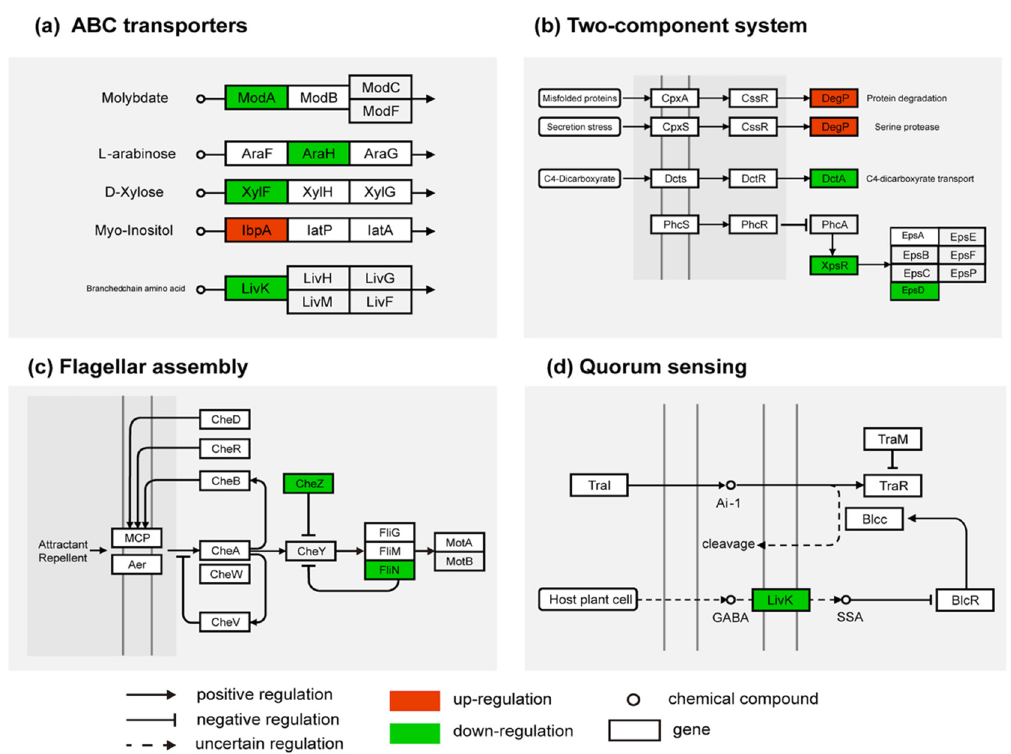
Figure 4. KEGG pathway of DEGs. ( a ) DEGs in the ABC transporter pathway. ( b ) DEGs in the two-component system. ( c ) DEGs in the bacterial chemotaxis pathway. ( d ) DEGs in the quorum sensing pathway. Red: upregulated by Si treatment; Green: downregulated by Si treatment.